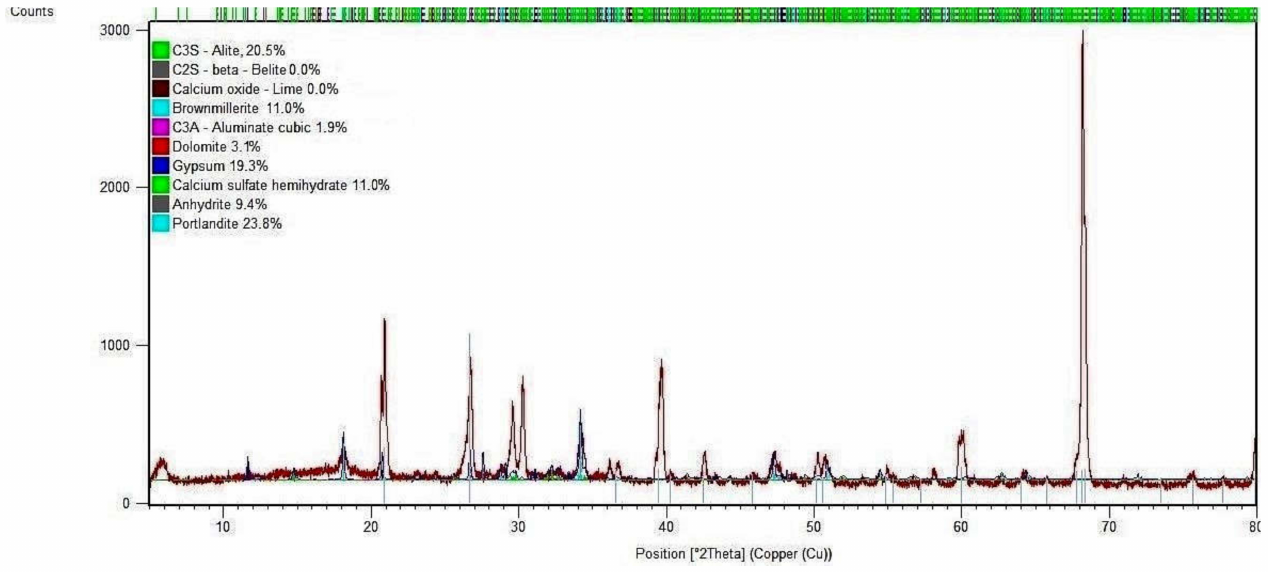
Figure 9. X-ray diffraction pattern of control mortar sample (OPC 42.5 R) after 7